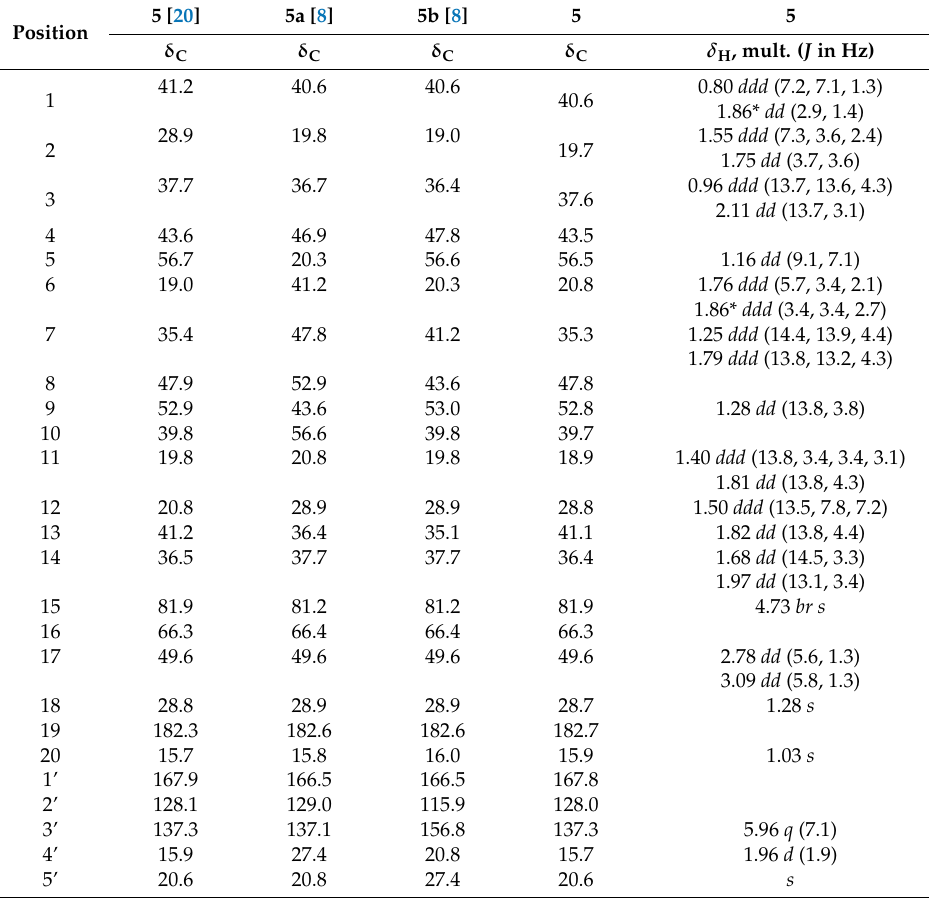
Table 2. The literature reported NMR data for 5 , 5a, and 5b and the 1 H (800 MHz) and 13 C-NMR (200 MHz) data for compound 5 acquired in CDCl 3